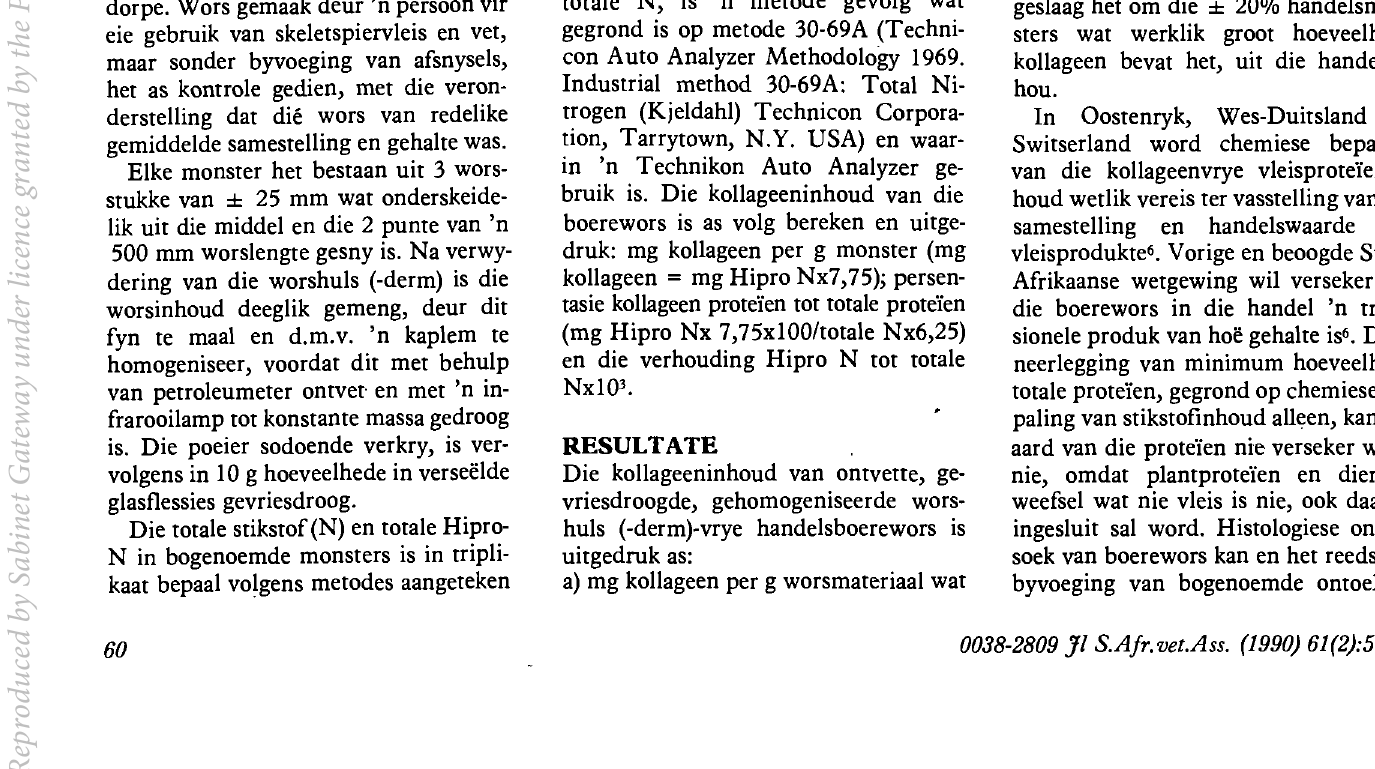
Fig. 1: Frekwensie-verdeling van die verhouding Hipro N tot totale N in 75 gevriesdroogde boereworsmonsters